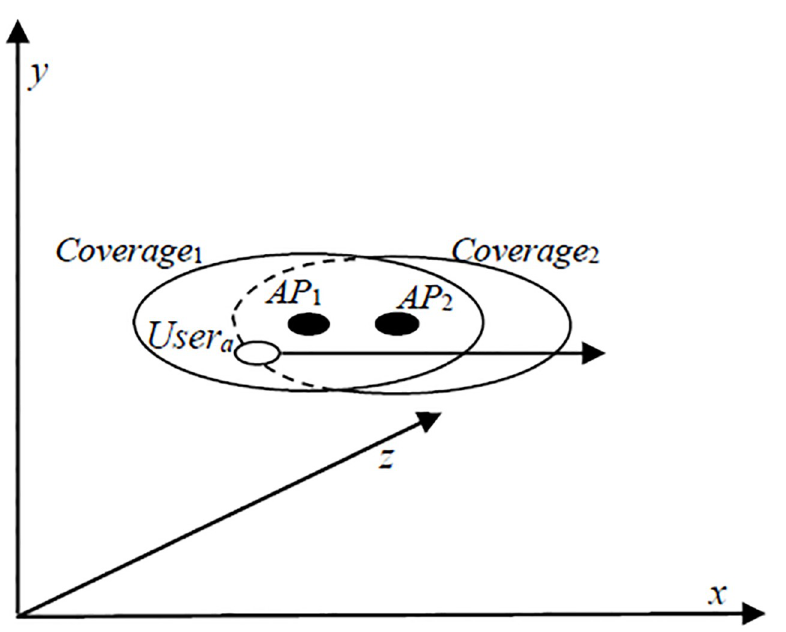
Fig 14. Visualization of WiFi signal